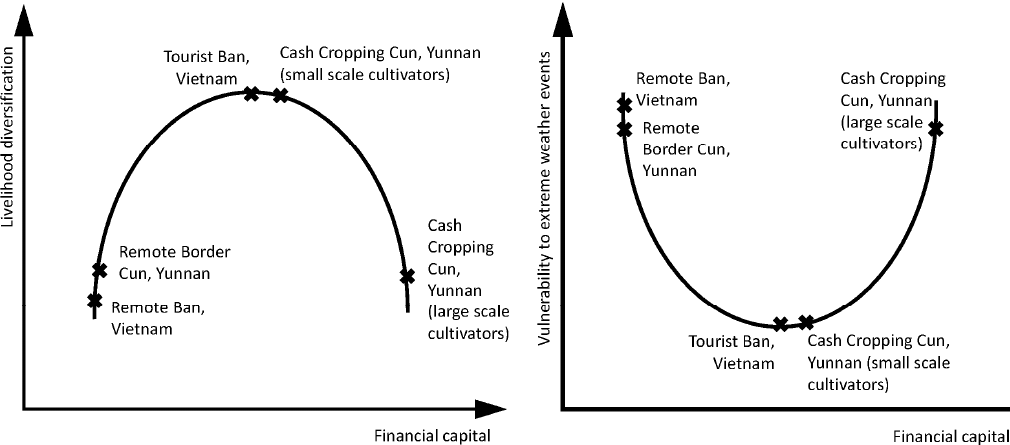
Figure 2. The four case study villages created an inverted U pattern with regards to livelihood diversification and financial capital and a U pattern when comparing vulnerability to extreme weather events and financial capital (axes show relative degrees of importance).